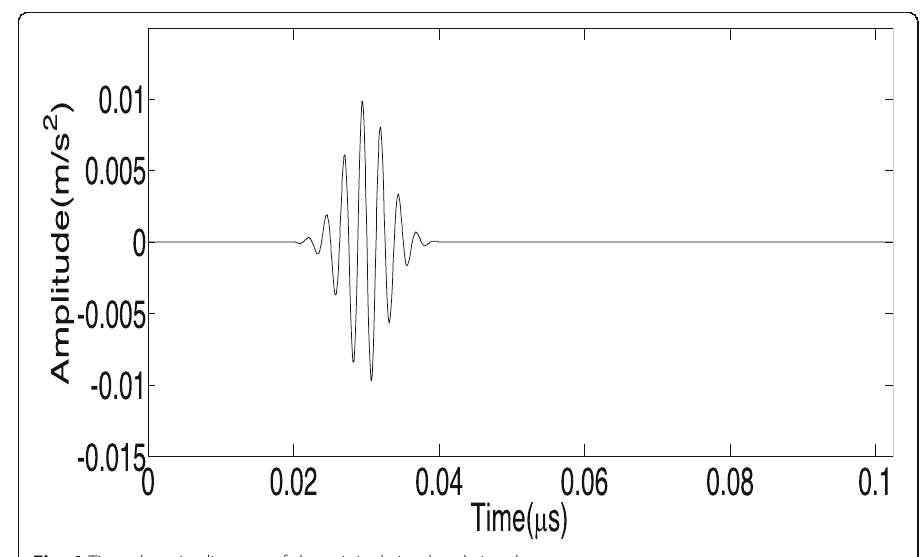
Fig. 4 Time-domain diagram of the original simulated signal